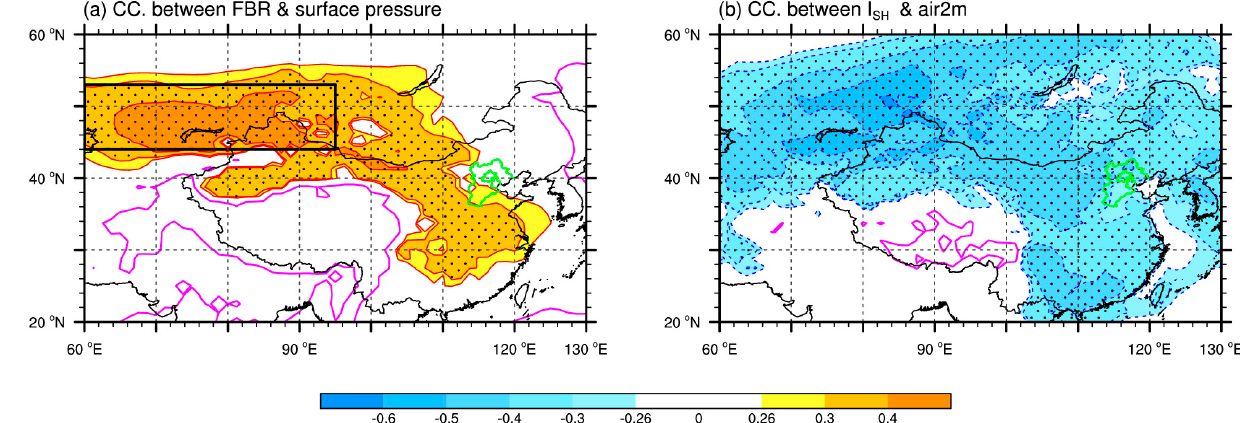
Figure 3. ( a ) Spatial distribution of correlation coefficients between FRB in BTH region and surface pressure in winter, where the rectangular box is the area selected to define Siberian high index (I SH ). ( b ) Correlation coefficient between I SH and 2 m temperature field. The solid magenta line denotes the zero line. The shaded area/dot shading is the area that passes the 90/95% significance test. Green curve indicates the BTH region.